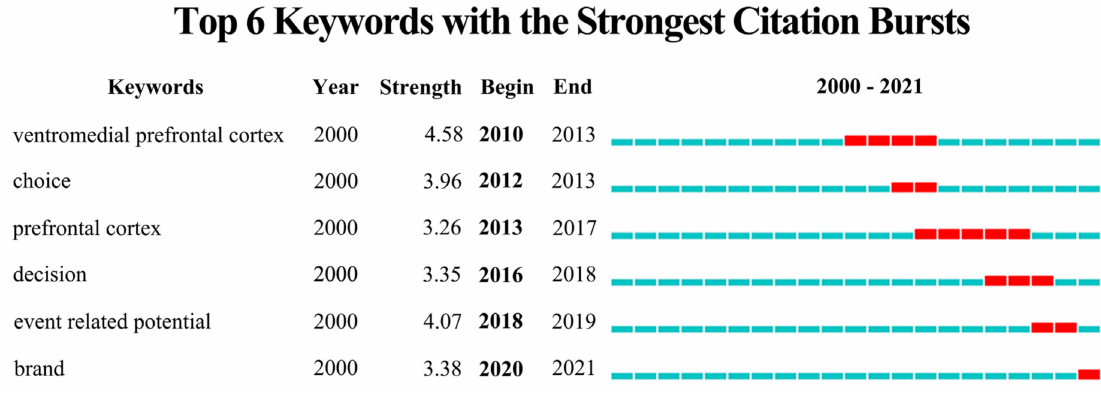
Figure 5. Top 6 keywords for burst